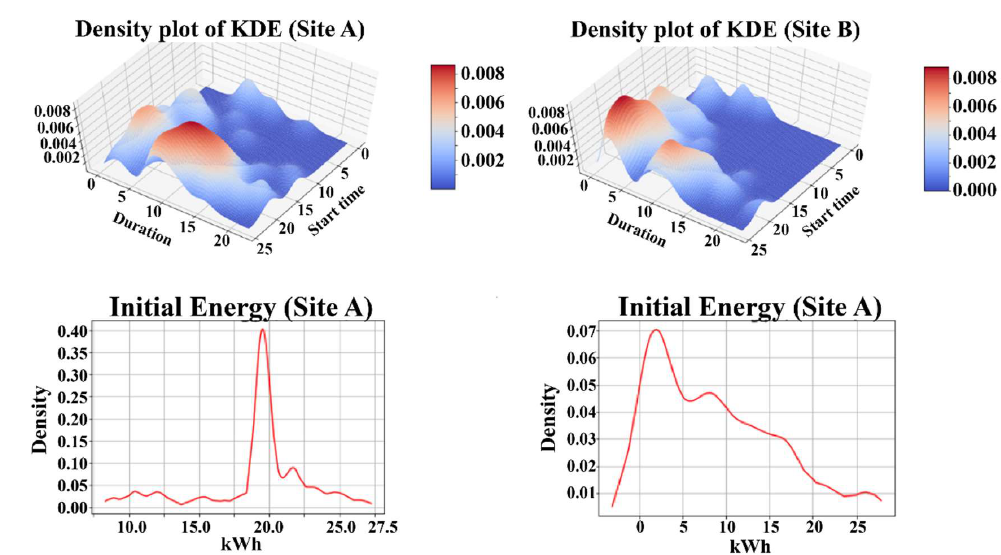
Figure 6. Estimated density functions and using KDE for Site A and B.